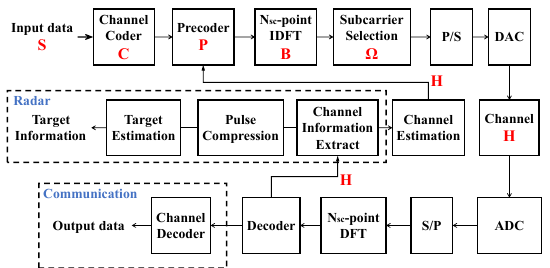
Figure 1. Multicarrier radio system for both multicarrier communication and multicarrier radar systems or a colocated radar-communication system. In the case of a radar or communication user, the dashed boxes of communication or radar in the block diagram are ignored. P/S (S/P) denotes parallel- to-serial or serial-to-parallel conversion, and DAC/ADC represents a digital-to-analog converter or analog-to-digital